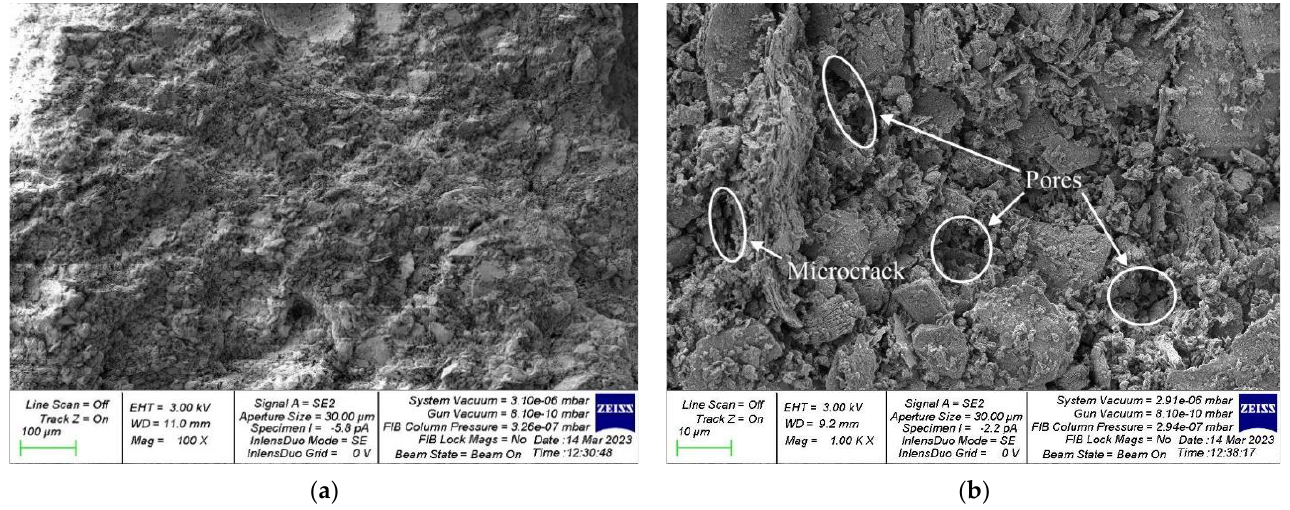
Figure 11. A sample of geopolymer concrete of the control composition: ( a ) 100×; ( b ) 1000×.